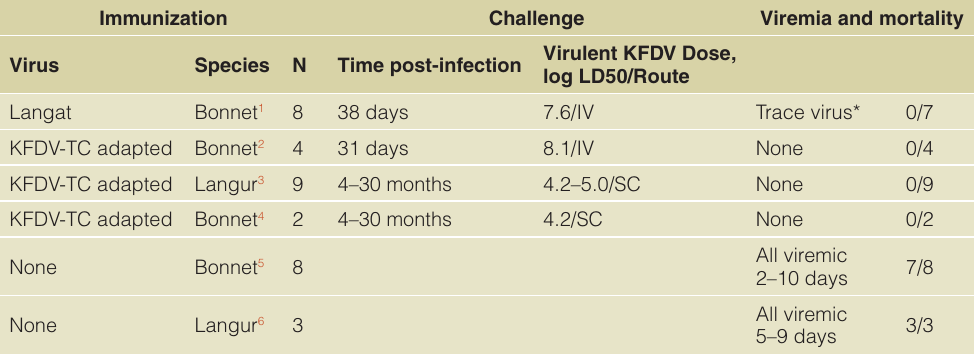
Table 6. Challenge of immunized monkeys with virulent